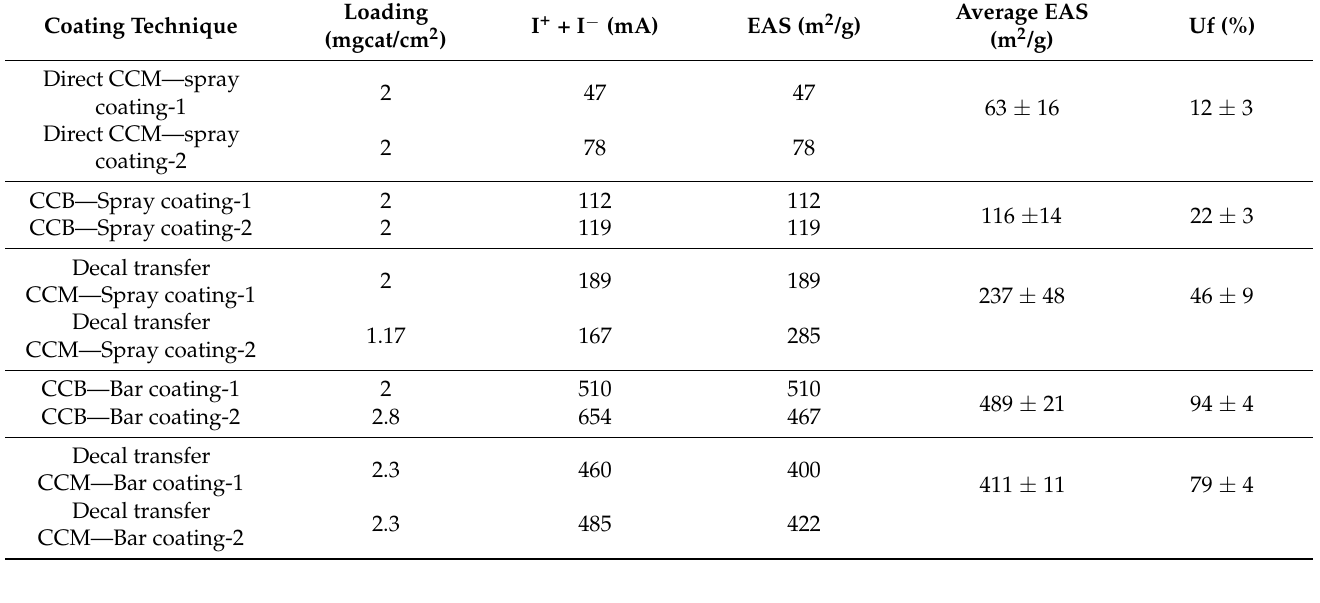
Table 1. EAS and Uf calculated for each printing technique used, with c = 0.2 F · m − 2 and S BET = 520 ± 20 m 2 /g.